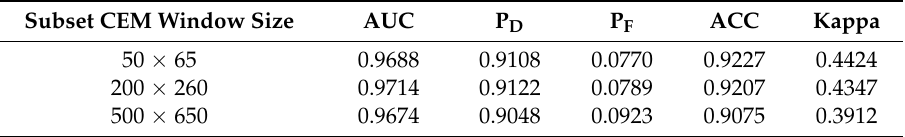
Table 6. Detection results of Subset CEM with various window sizes.